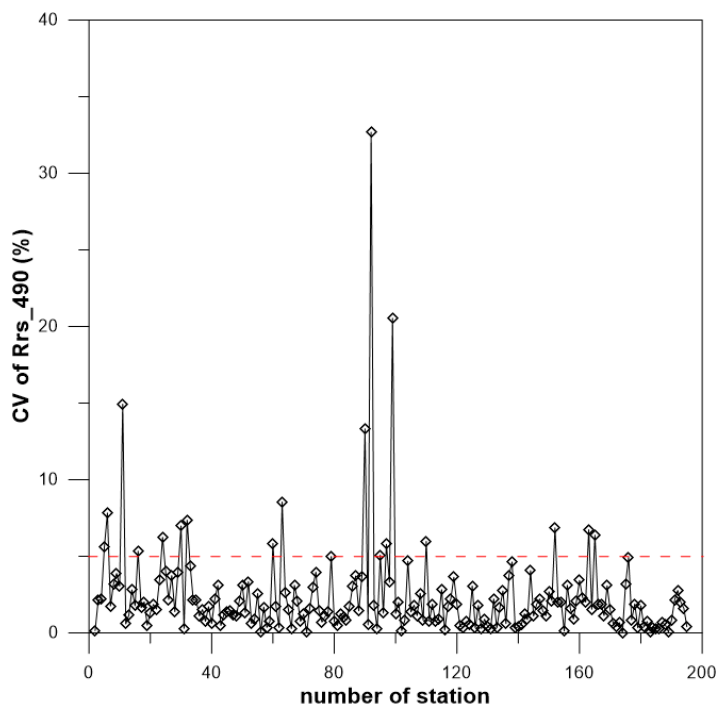
Figure 1. Stations of the China Sea used in the stud y.